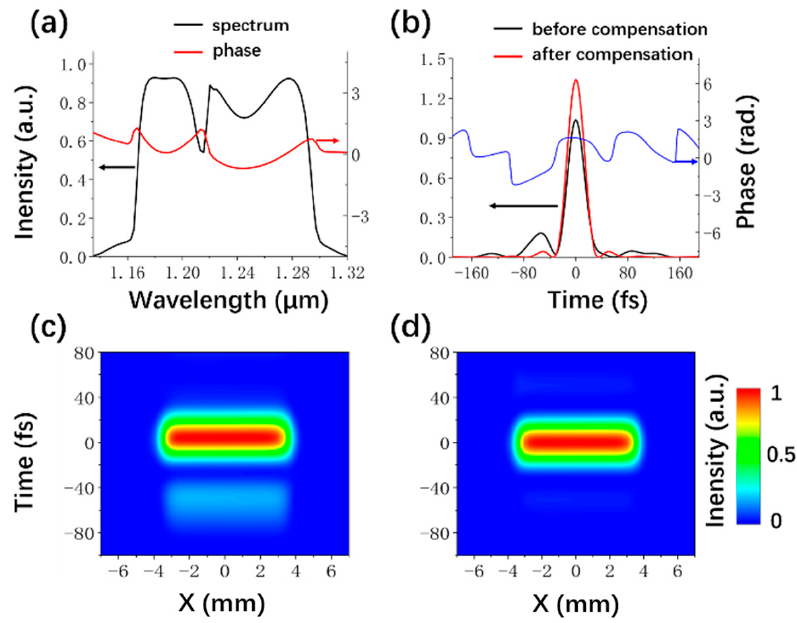
Figure 5. ( a ) The amplified spectrum and the spectral phase after dispersion compensation up to TOD for double-crystal scenario, ( b ) the temporal profiles of signal before and after the high order dispersion compensation, the temporal distributions of the signal along X axis ( c ) before and ( d ) after the compensation of the high order dispersion.